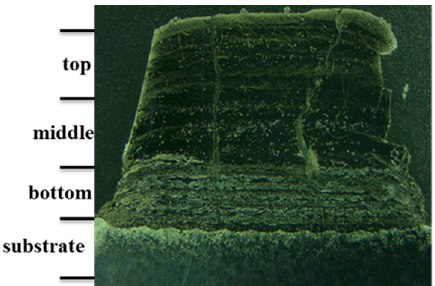
Figure 4. Surface cracks and different textures.